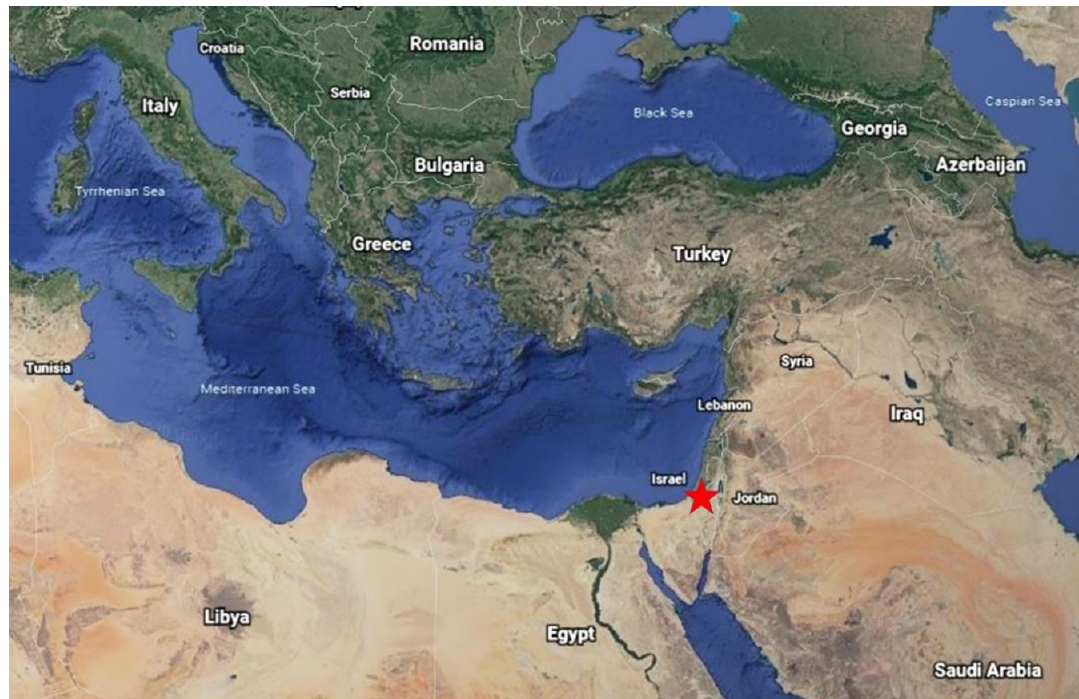
Figure 1. Map of the region showing Be’er Sheva (red star). From Google Earth.